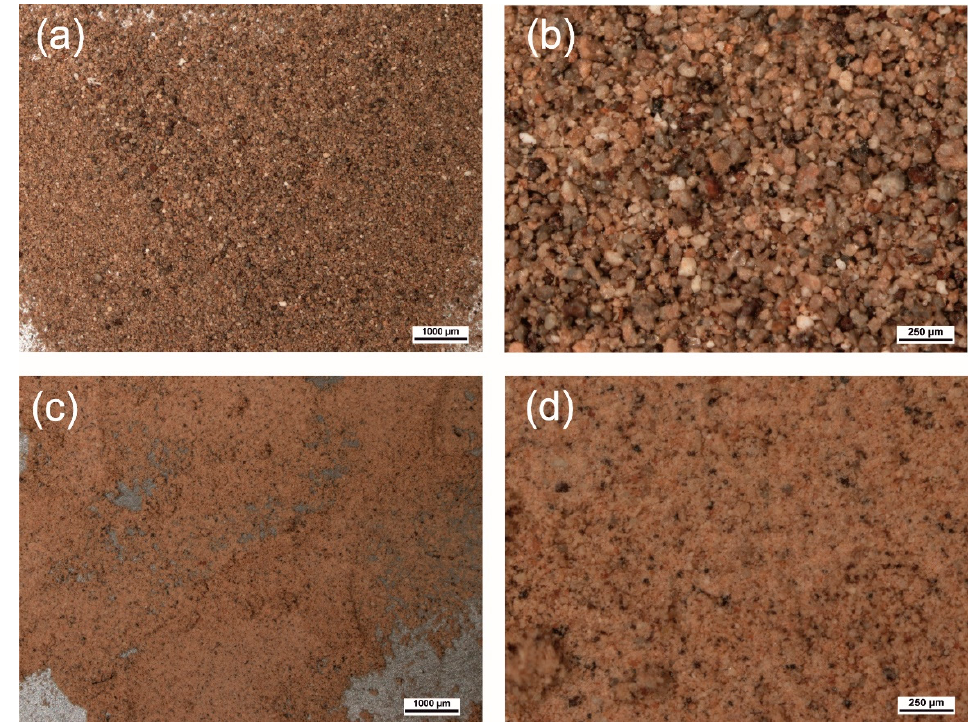
Figure 3. Microscopic images of thermally treated BCV 2017: ( a , b ) a crust that formed on the surface of the sample; ( c , d ) bulk material. Note the difference in grain size between the crust and bulk material.